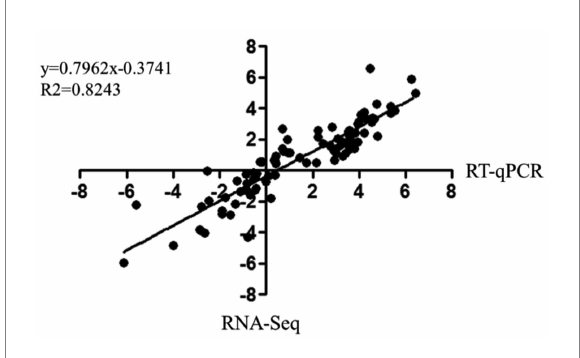
FIGURE 6 Correlation of fold change analysed by data obtained using RT- qPCR (x-axis) with RNA-Seq platform (y-axis). Correlation analysis was performed using GraphPad software 6.0 (San Diego,